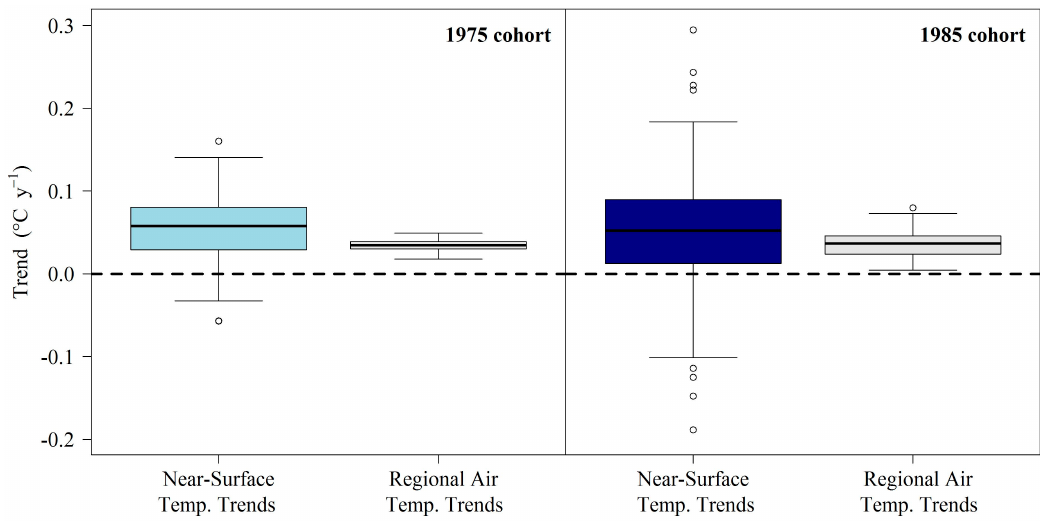
Figure 3. Box plots showing the trends in lake near-surface temperature for NENA lakes and in regional air temperature for both the 1975 cohort (left panel) and 1985 cohort (right panel). In both cohorts, the near-surface temperature trends are significantly greater than the corresponding regional air temperature trends (two-sample t -tests: p < 0.001 and p < 0.001, respectively). In boxplots, boxes span the first through third quartiles with the median trend represented by the thick center line with whiskers adding the ± 1.5 interquartile range to the boxes. Open circles are individual points that fall outside that span.